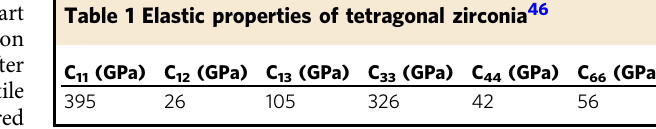
Table 1 Elastic properties of tetragonal zirconia